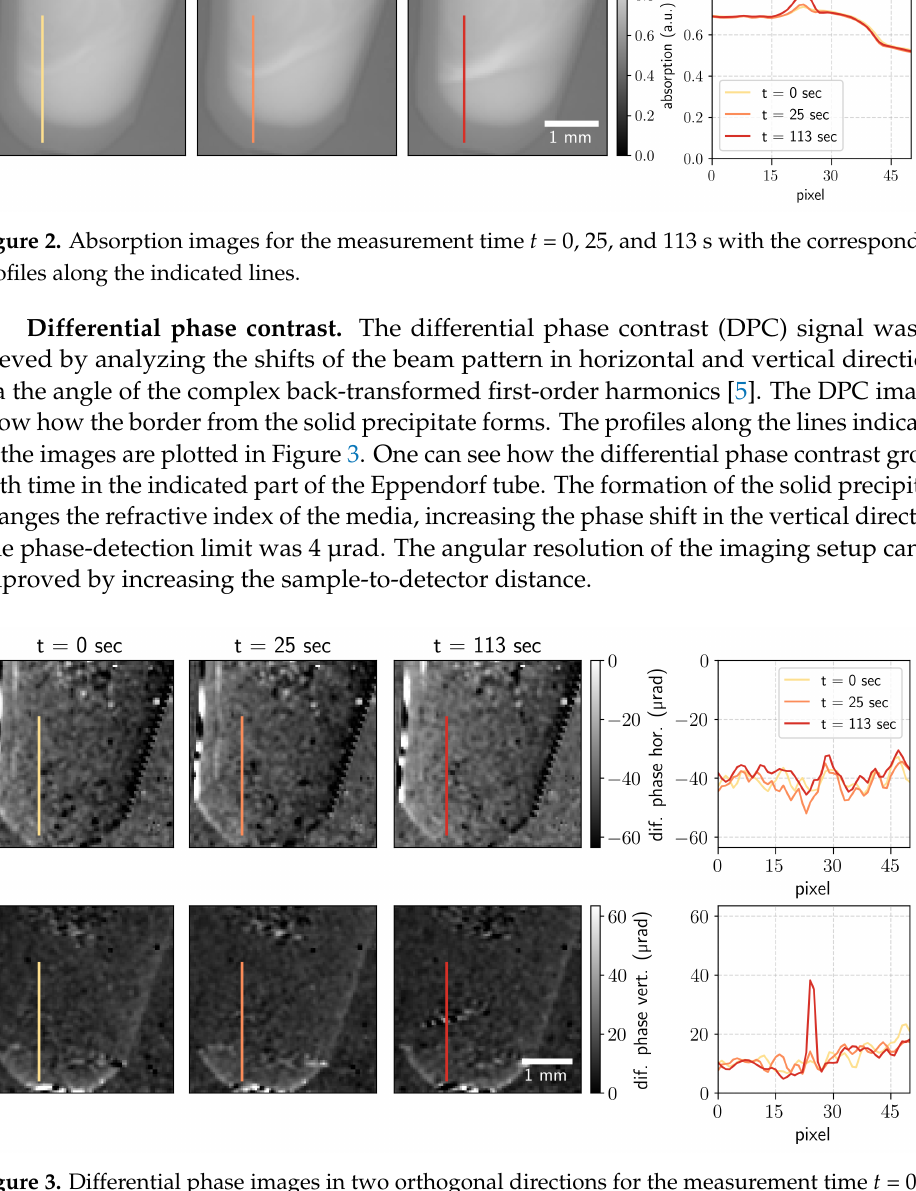
Figure 3. Differential phase images in two orthogonal directions for the measurement time t = 0, 25, and 113 s and the corresponding differential phase profiles along the indicated